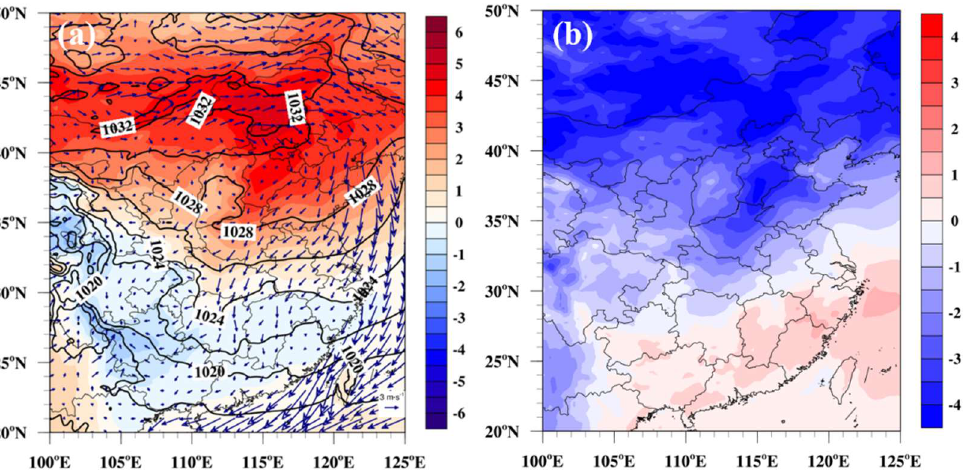
Figure 4. ( a ) Mean sea-level air pressure (hPa, black lines), wind vectors (m·s −1 ) during 30 HPEs, and anomalies of sea-level air pressure (color shadings), ( b ) 2 m air temperature (°C) during 30 HPEs in the THB relative to the five-year climatology (2015–2019).